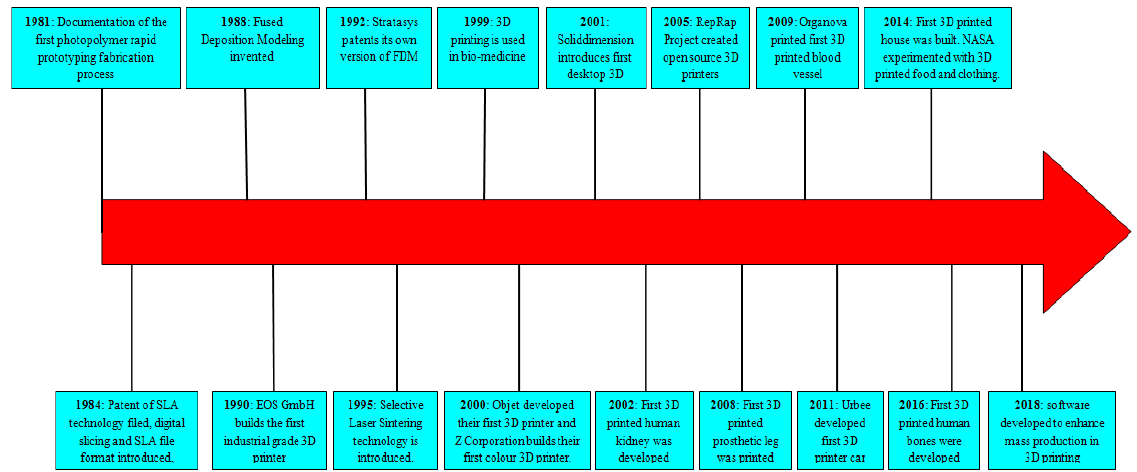
Figure 1. History and landmark achievements in 3D printing timeline from the 1980s to today.